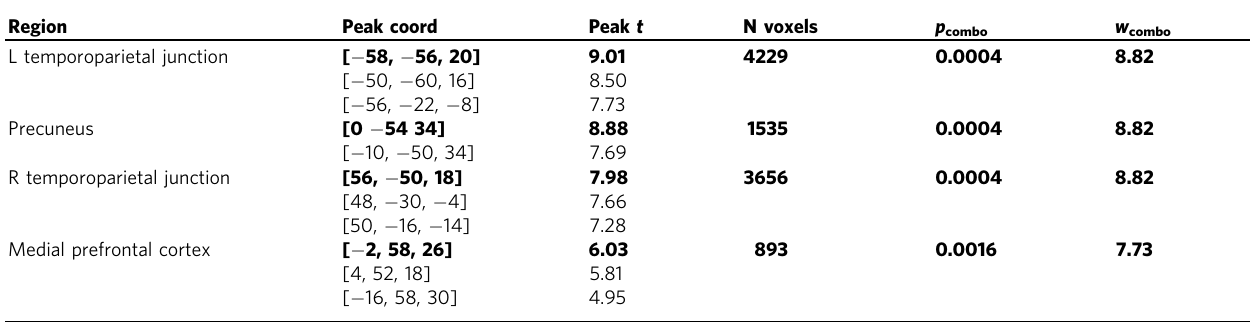
Table 1 Theory of mind brain regions preferentially respond to mental-state stories. Region Peak coord Peak t N voxels p combo w combo L temporoparietal